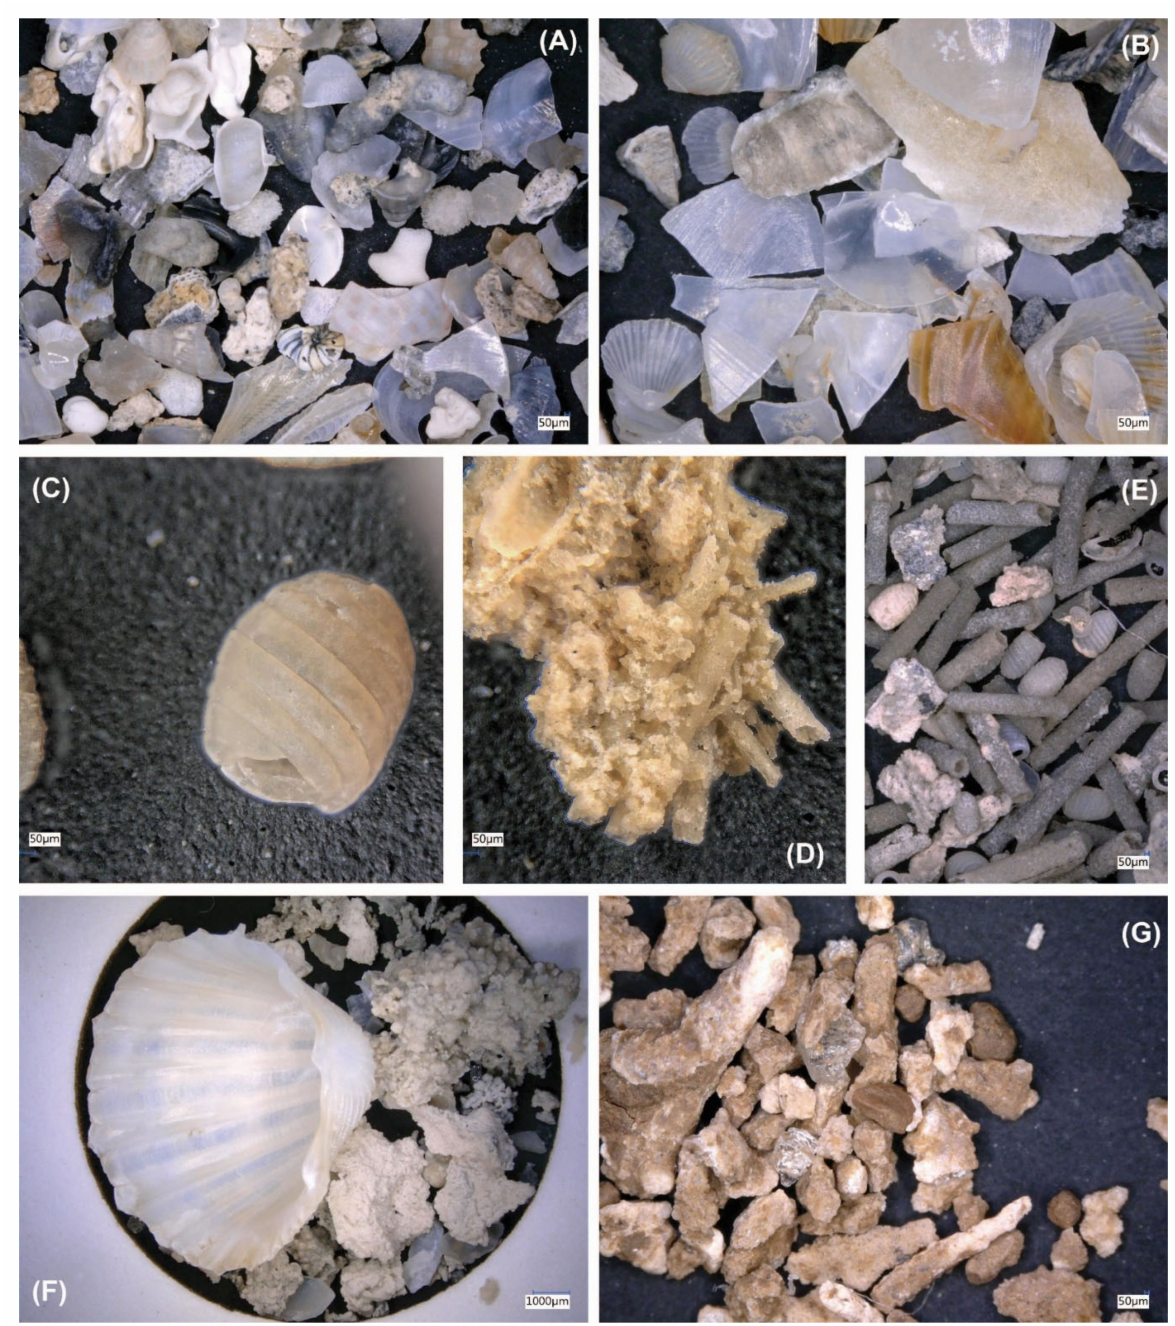
Figure 3. ( A , B ) mollusc fragments, ( C ) Gyrogonite (Charophyte oogonial cell), ( D ) Calcified re- mains of a charophyte cortex (thalli encrustation), ( E ) Calcified Charophyte cortex and Gyrogonites, ( F ) Bivalve ( Acanthocardia paucicostata ), and carbonate aggregates, ( G ) Clastic grains and fish bones. The age model of core ASTC1 was based on 20 bulk 14 C org measurements and one 14 C accelerator mass spectrometry (AMS) measurement on benthic foraminiferal tests of the species Ammonia tepida (Figure 4, Table 1). The 14C analysis for the shell test was carried out at the Radiochronology Lab C.E.N. ULAVAL in Canada, whereas the 14 C dates were conducted at